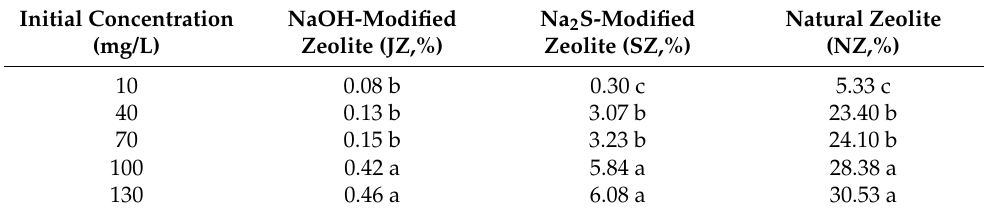
Table 4. Desorption rates of Cd by modified and natural